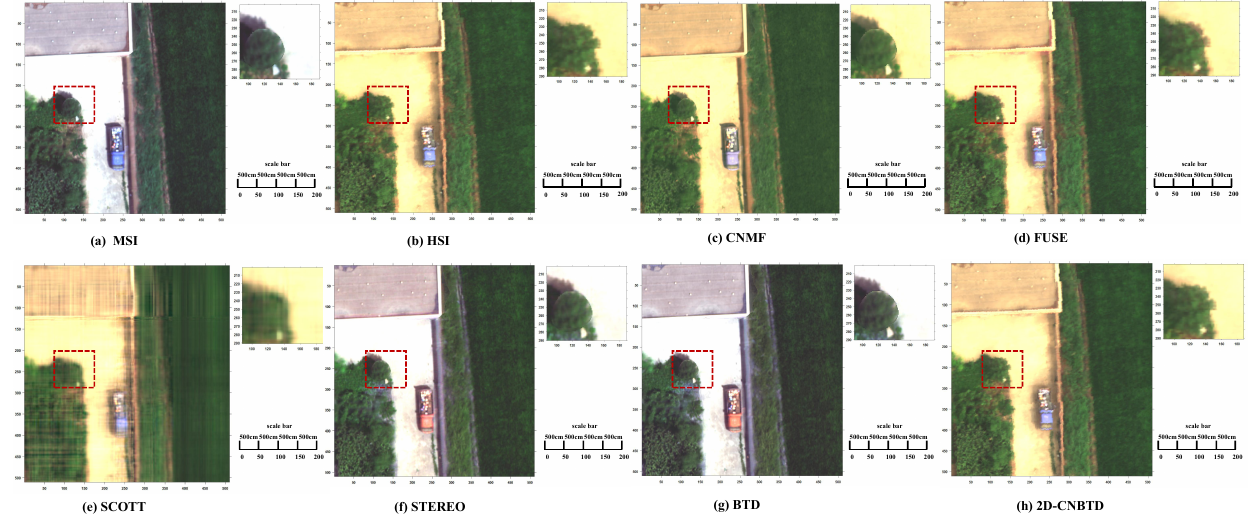
Figure 12. Plot of fusion results of UAV acquisition of Qingtongxia rice field